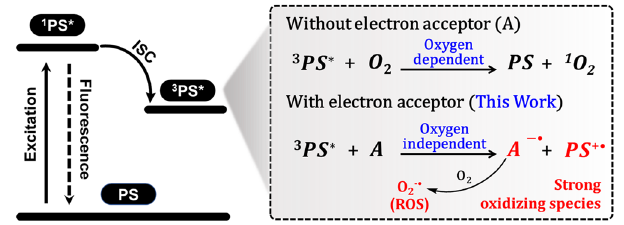
Fig.1|Mechanismforthegenerationofoxidizingspecies. Therelaxpathwaysof 3 PS* with or without electron acceptor.